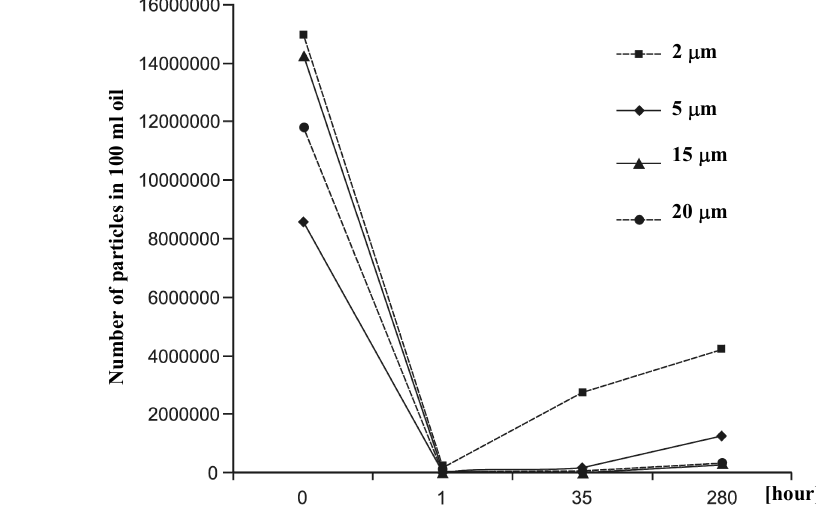
Figure 5 – Increase in the oil contamination level in 280 operating hours Slika 5 – Pove ć anje kontaminacije ulja za 280 radnih č